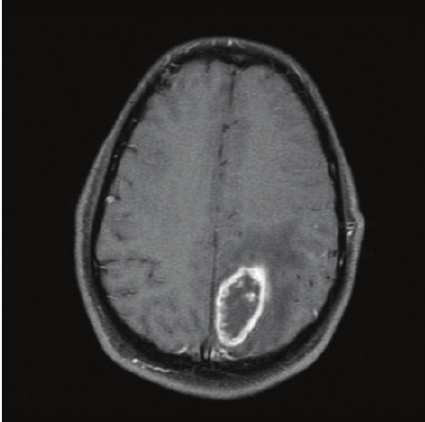
Figure 1: MRI scan obtained after this patient initially presented to the emergency department demonstrating 4.5 cm, ring-enhancing, left parietal mass with surrounding edema consistent with GBM.